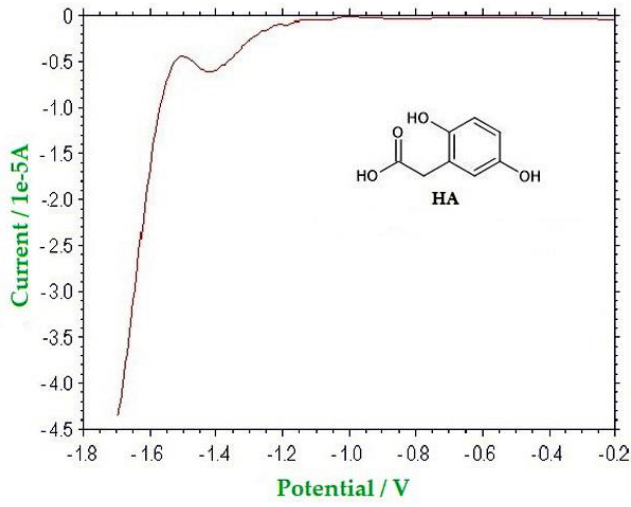
Figure 6. SW voltammogram of HA (0.1 mmol dm − 3 ) in 0.1 mol dm − 3 LiCl aqueous solution, WE: Hg; AE: Pt; RE: SCE. Potential scan rate: 0.10 V s − 1 ; pulse height: 4 mV; frequency: 15 Hz; modulation amplitude: 25 mV.